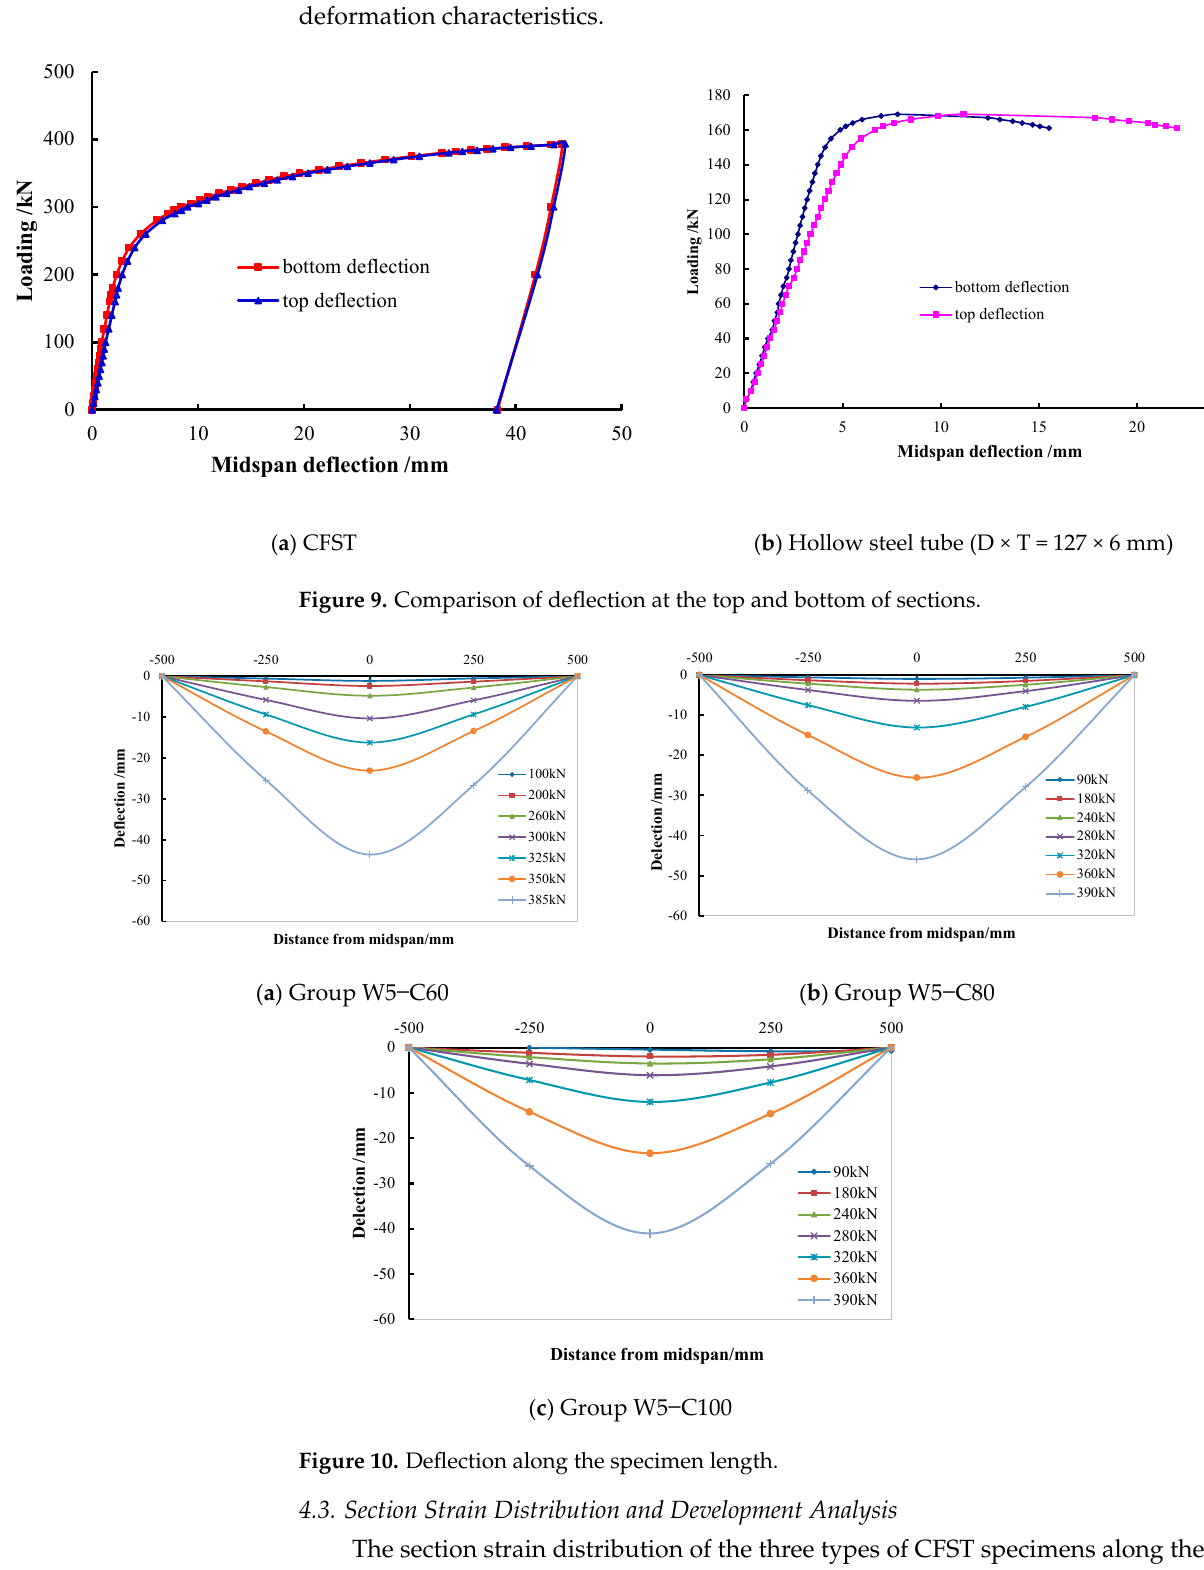
Figure 8. Comparison of three different specimens’ P– ω curves.